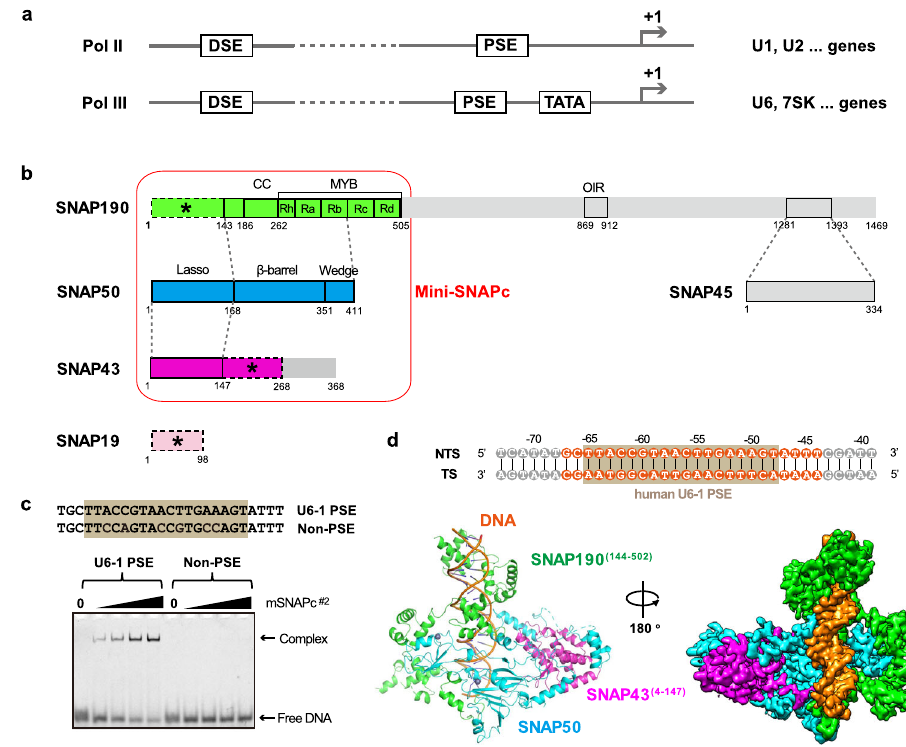
Fig. 1 | Overall structure of human mini-SNAPc complexed with U6-1 PSE. a Schematic diagram of two types of human snRNA promoters to recruit Pol II or Pol III. b Five-subunit hSNAPc composition with detailed domain organization. SNAP190 (1-505) is shown in green, SNAP50 in cyan, SNAP43 (1-268) in magenta, and SNAP19 in pink. The domain – domain interactions are indicated using dash